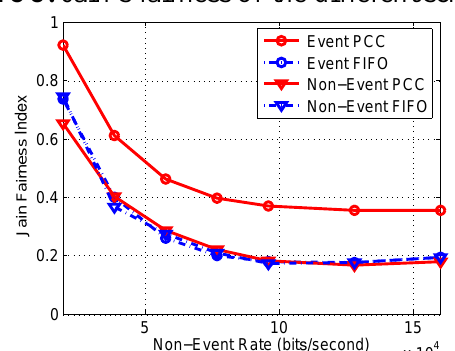
Figure 8. Jain’s fairness of the different schemes.